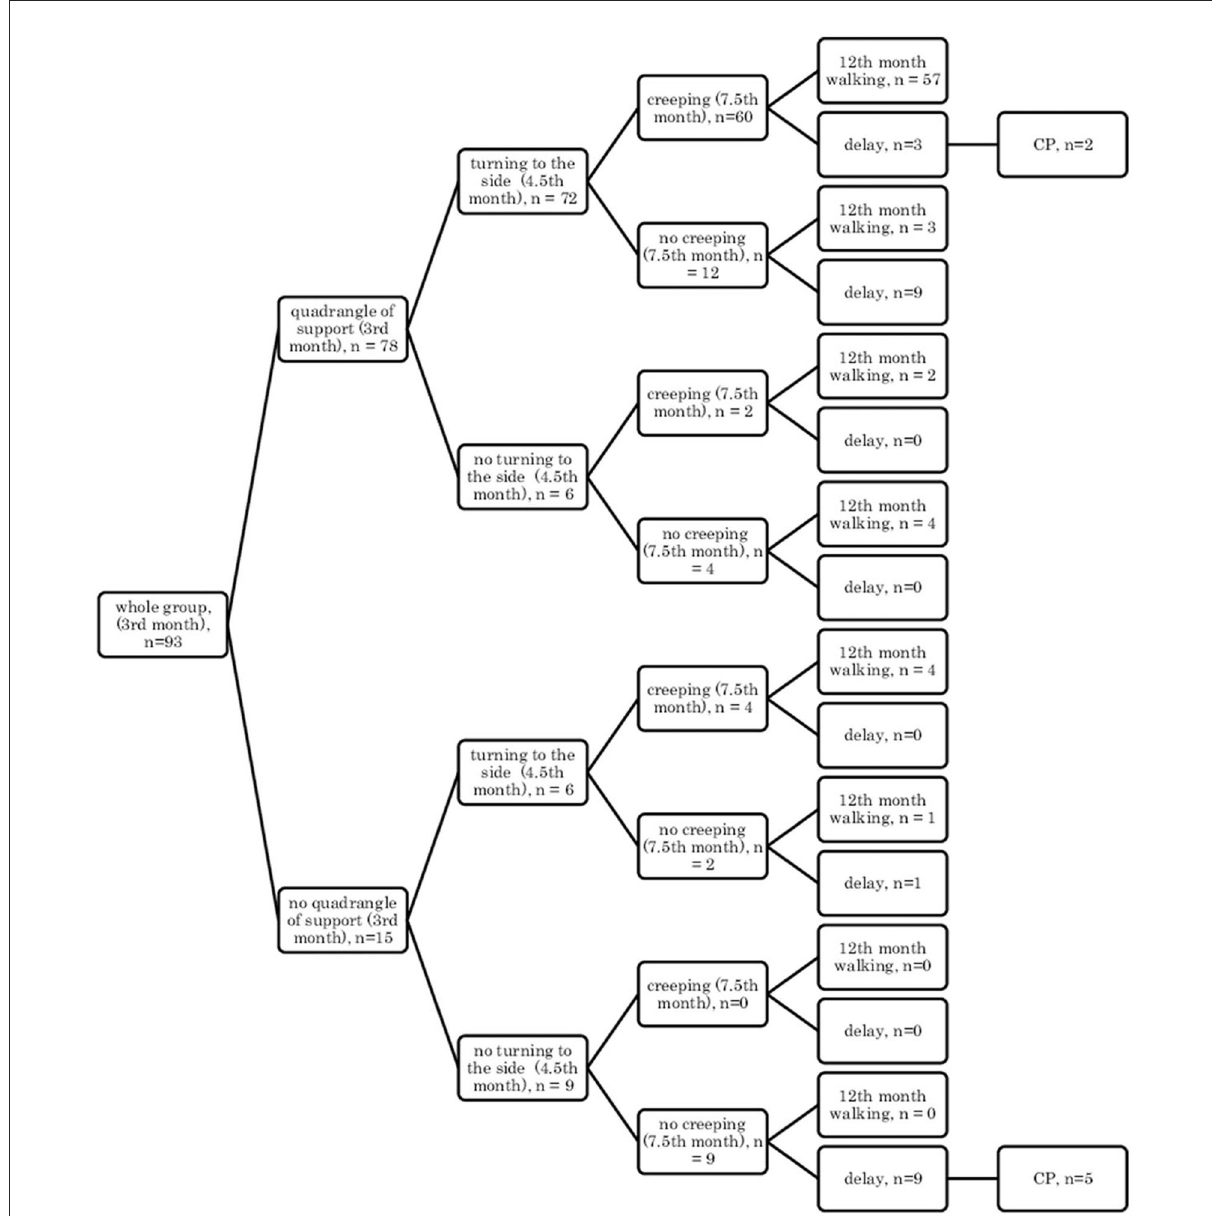
FIGURE1 Motor development in the supine position: a quadrangle of support (3rd month); turning to the side (4.5th month); creeping (7.5th month), and independent walking (12th